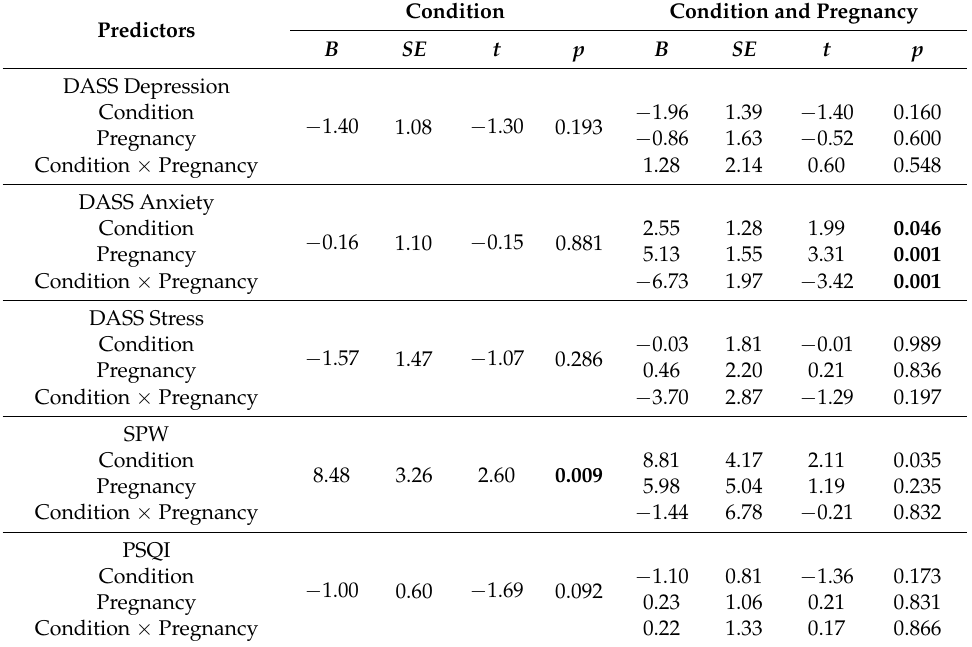
Table 3. Multiple regression analyses for stress and stress-related symptoms at T2, condition, and